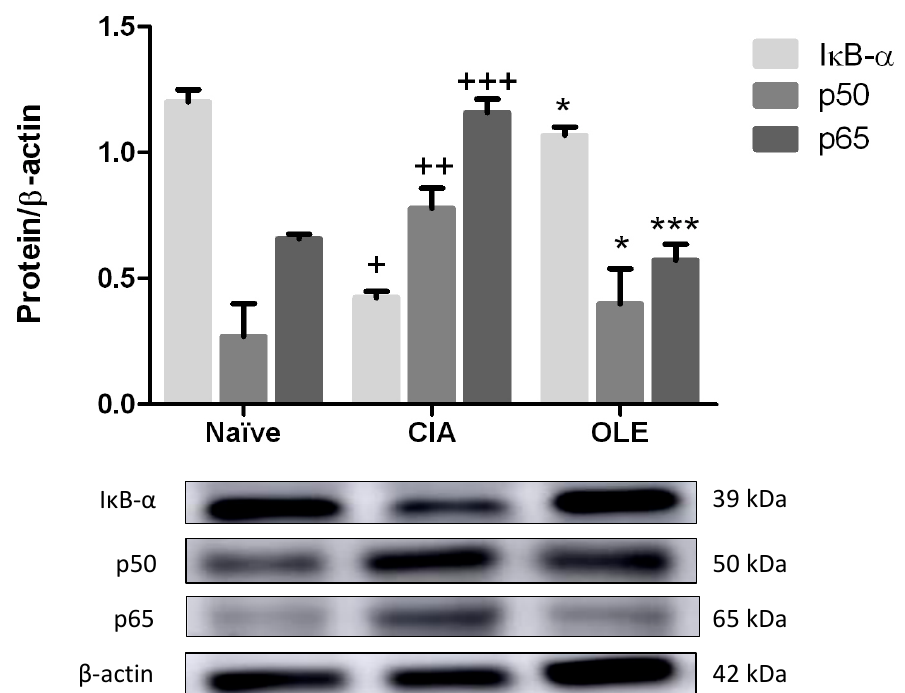
Figure 10. OLE diet-enriched controlled NF- κ B signaling pathway preventing I κ B- α degradation and p65 and p50 subunits migration to the nucleus. The expression was quantified by densitometry anal- ysis and normalized with respect to β -actin (house-keeping). Western blot images are representative of separate experiments with similar results. Naïve group, non-arthritic control animals fed with SD; CIA, control group induced arthritic animals fed with SD; OLE induced arthritic animals fed with OLE enriched diet (0.025% w/w ). Values represented mean ± S.E.M. ( n = 8), + p < 0.05; ++ p < 0.01; +++ p < 0.001 vs. Naïve group; * p < 0.05; *** p < 0.001 vs. CIA group.